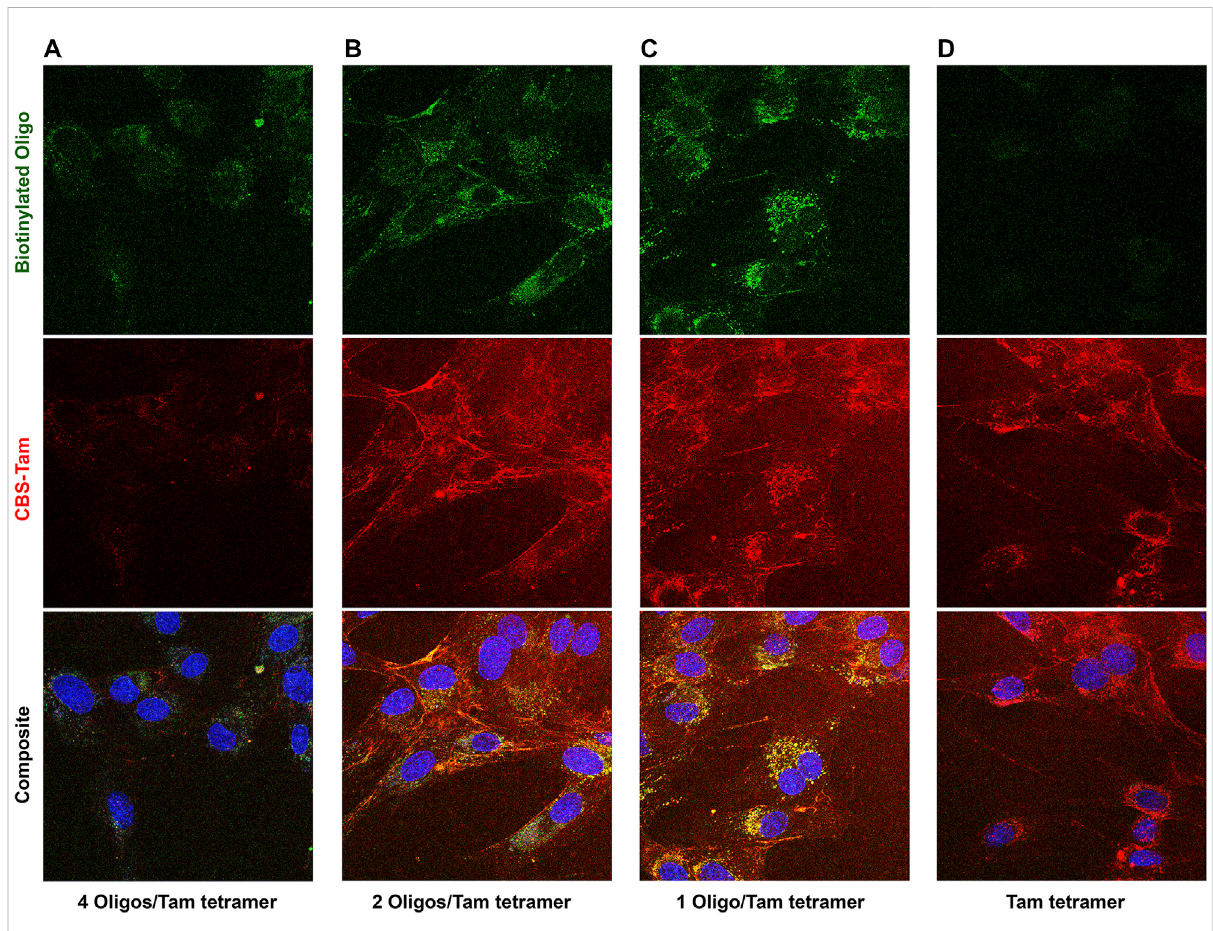
FIGURE 4 CBS-Tam, a cargo made from the fusion of CBS to the fungal avidin, tamavidin, internalizes model oligos but only at stoichiometries below 2oligosperCBS-Tamtetramer.BHKcellswereincubatedwith600 nMTAT-CaM/Tam complexesboundtoanoligowitha5 ′ Alexa488dyeanda3 ′ biotin present at concentrations of (A) 600, (B) 300, (C) 150, or (D) 0 nM oligo for 1 h prior to washing (PBSx3) and